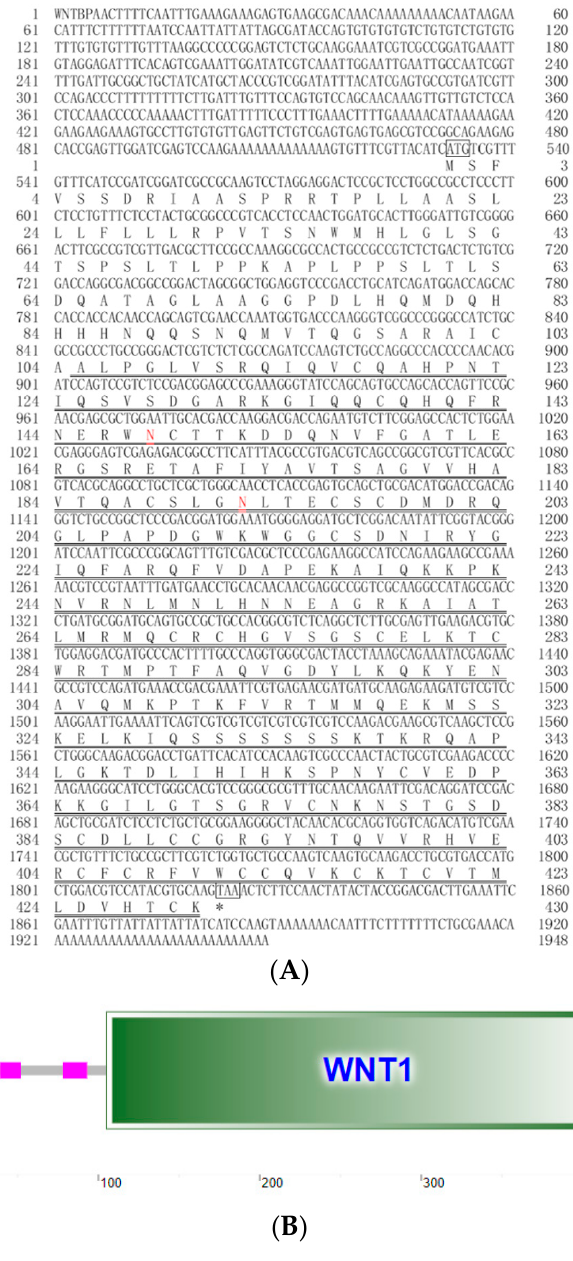
Figure 2. Nucleotide and deduced amino acid sequences of DpWnt16 ( A , B ). Start (ATG) and stop (TGA/TAA) codons are marked with boxes. The Wnt1 domain is indicated by double underlines. The N-glycosylation sites are highlighted in red. The three pink rectangles represent the low-complexity regions ( B ).